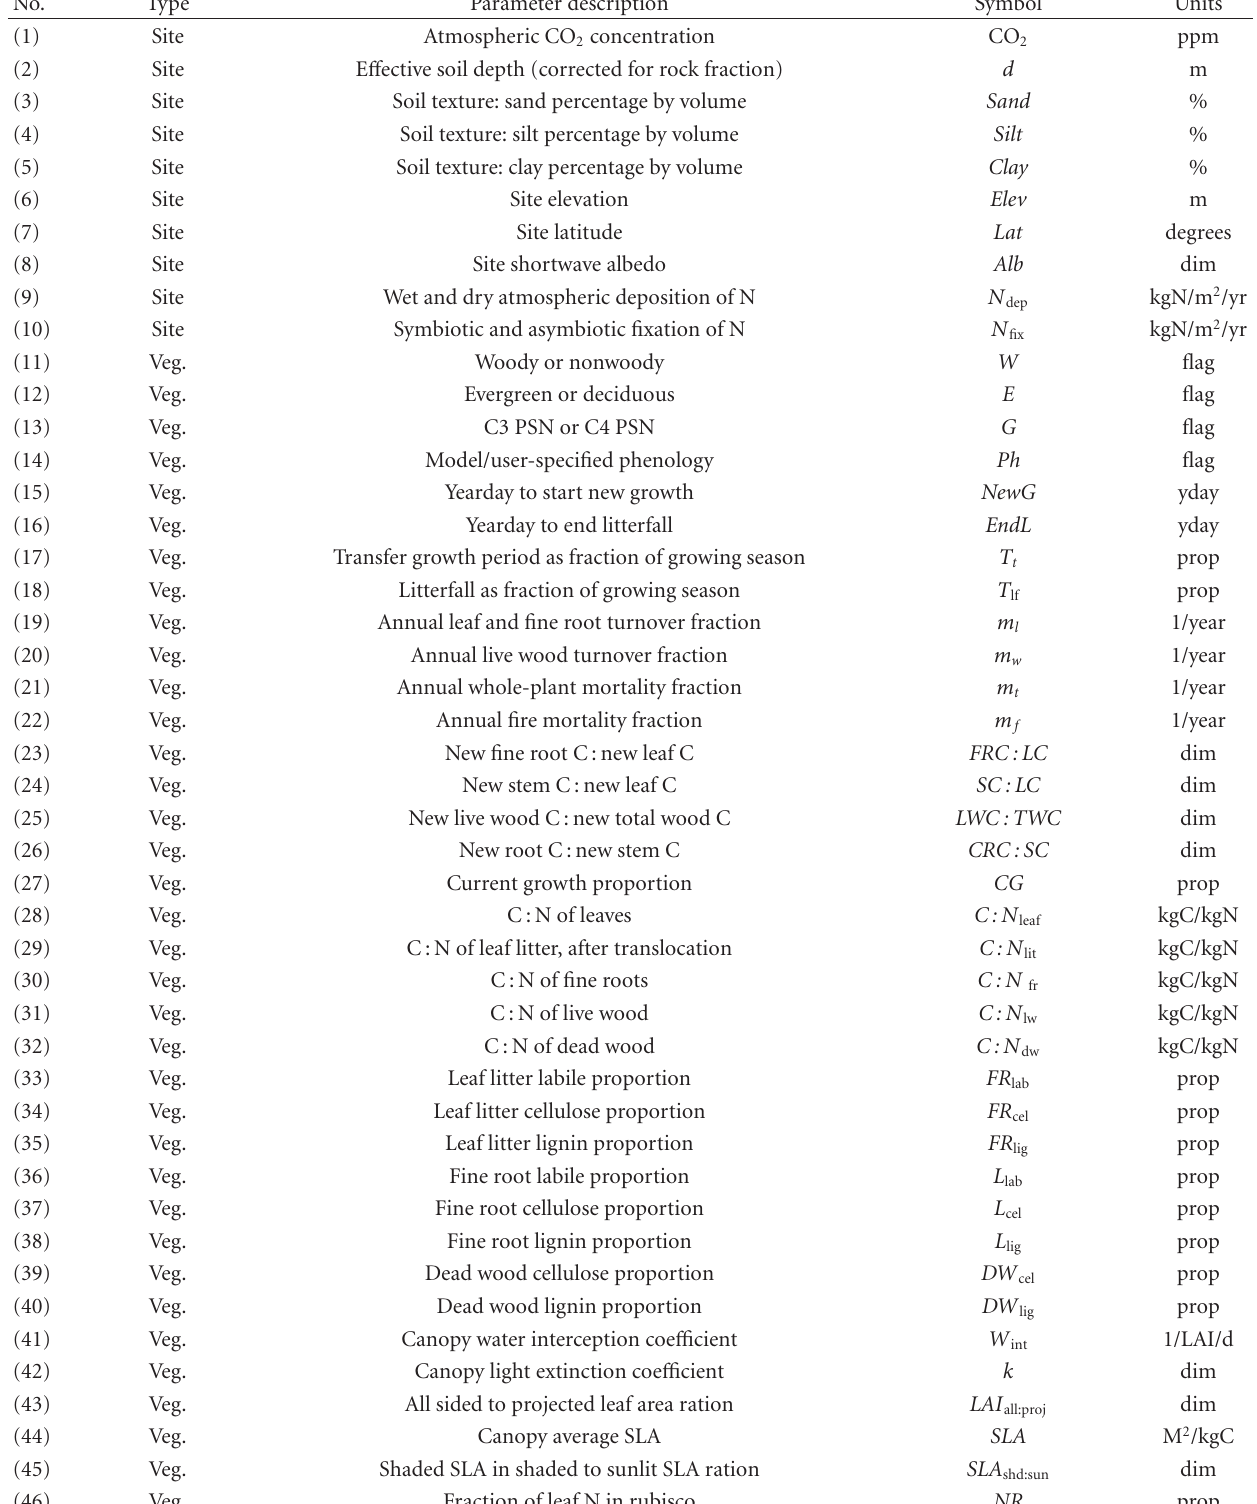
Table 1: Site and vegetation input parameters for Biome-BGC model. Type site refers to physical characteristics of the site, whereas type vegetation refers to ecophysiological constants with description of the vegetation type to be simulated. The units specified as dim indicate dimensionless. Model predictions are most sensitive to parameters indicated in